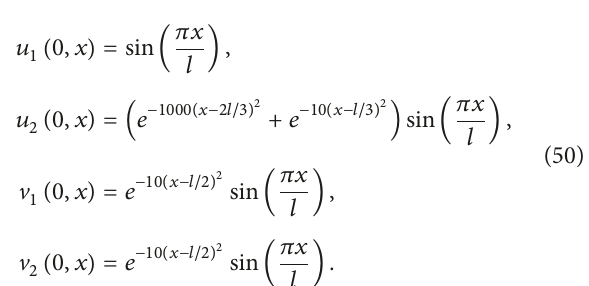
𝑑 = 5×10 −4 , 𝑎 = 0.028 , and 𝑏 = 0.053 , and initial conditions 2 are given